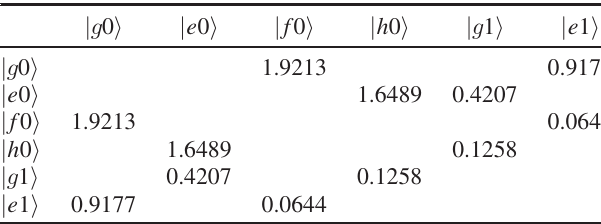
TABLE III. Two-photon matrix elements × 10 3